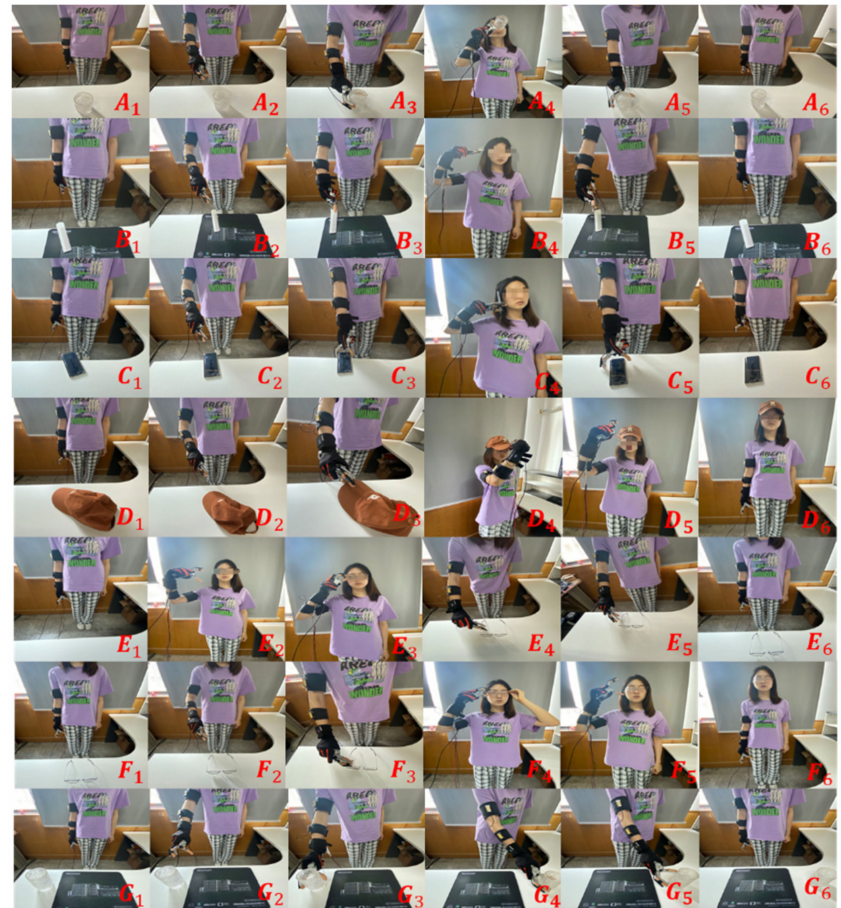
Figure 12. Seven kinds of action flow. A 1 – A 6 represents the action of drinking water; B 1 – B 6 represents the action of combing hair; C 1 – C 6 represents the action of answering the phone; D 1 – D 6 represents the action of putting on a hat; E 1 – E 6 represents the action of wearing glasses; F 1 – F 6 represents the action of taking off glasses; G 1 – G 6 represents the action of moving a